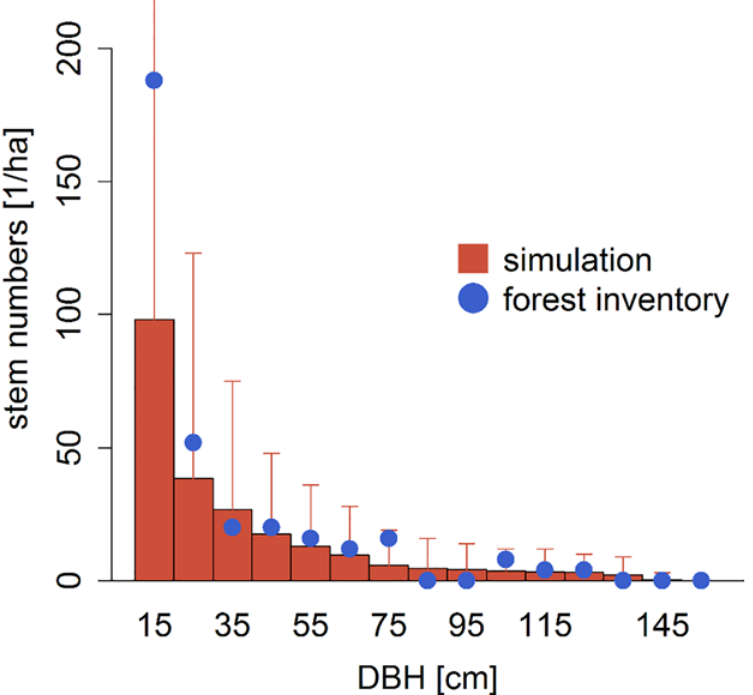
Fig 3. Simulated stem size distribution. Number of trees for different DBH — classes. The red bars indicate the simulated stem size distribution with its variation. The blue line indicates the measured stem size distribution for the investigated forest at Mt.